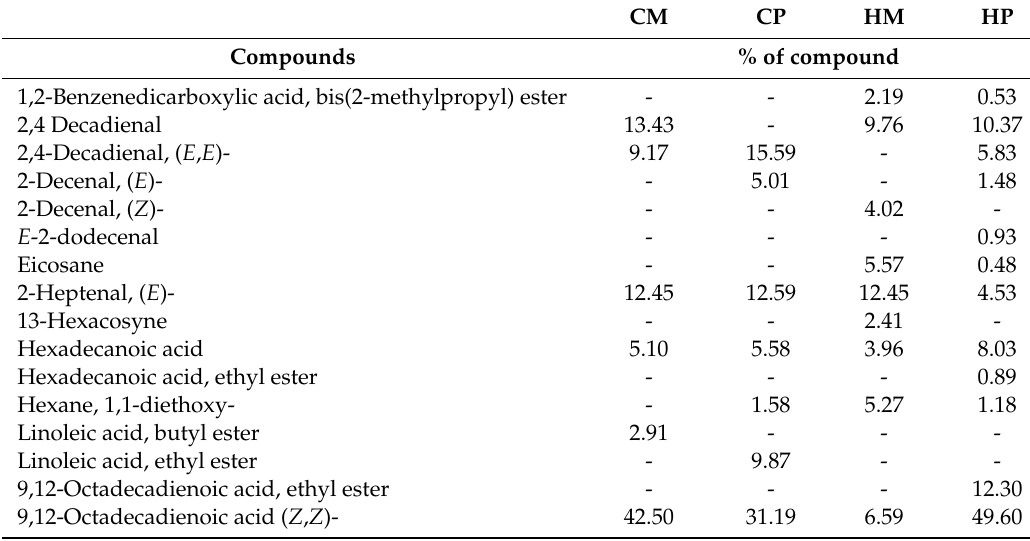
Table 2. GC-MS analysis of the extracts.